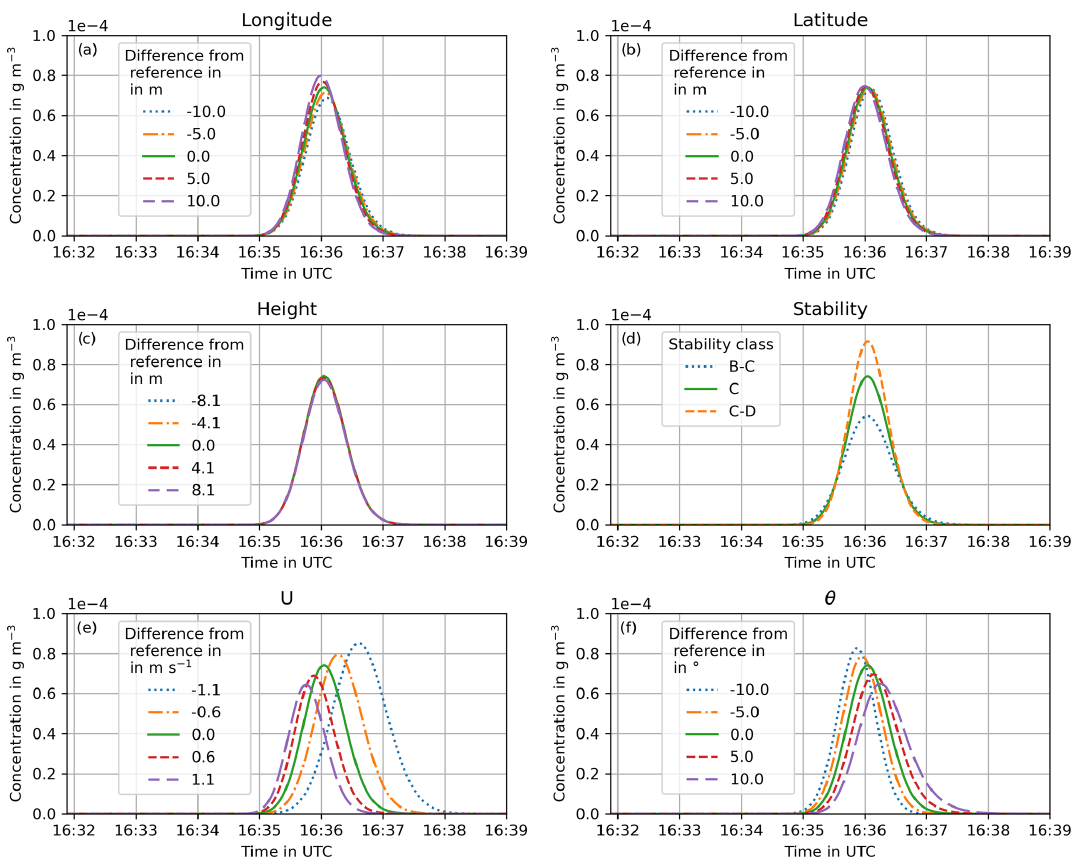
Figure C1. Monte Carlo simulations for the example plume shown in Fig. 4. In each plot, one parameter has been changed within its respective uncertainty, and the resulting model peaks are shown. The uncertainties shown in the plot legends are always expressed as a deviation from the reference simulation; e.g. in plot (a) , − 10m means that the ship positions have systematically been moved 10m to the west, while 10m means each position has been moved 10m to the east. The reference simulation (no uncertainty) is shown as a solid green